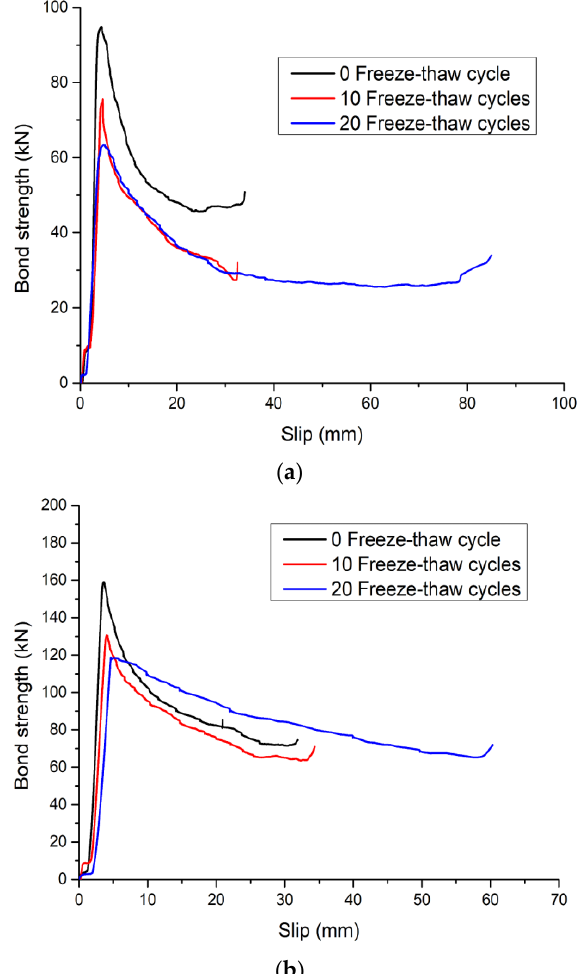
Figure 10. Load–slip curve of round steel tube push-out specimen: ( a ) C30; ( b ) C45 (the data in the figures are averaged).